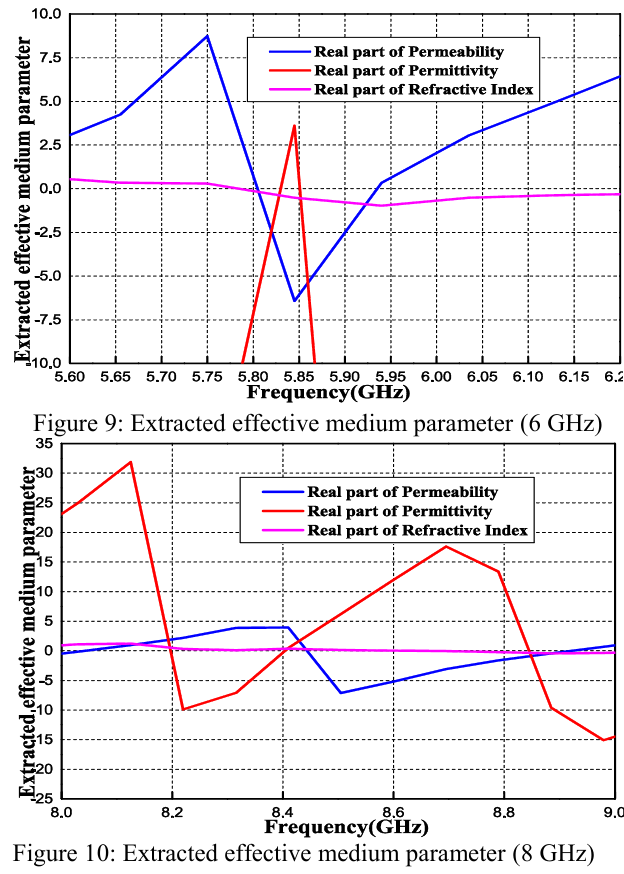
Figure 10: Extracted effective medium parameter (8 GHz)